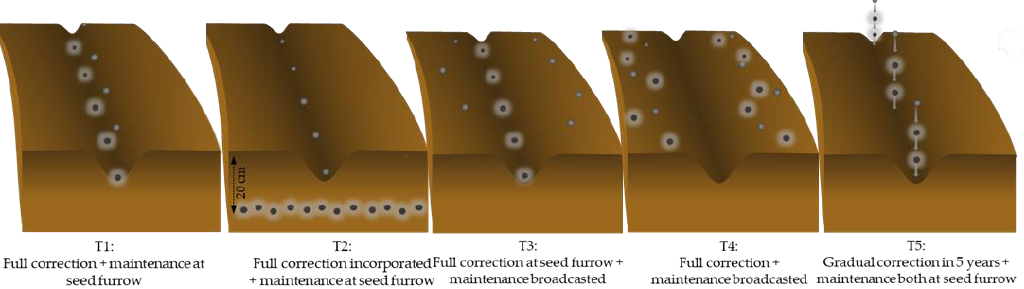
Figure 1. Illustration of the treatments of experiment 1, phosphate management for soil P buildup.